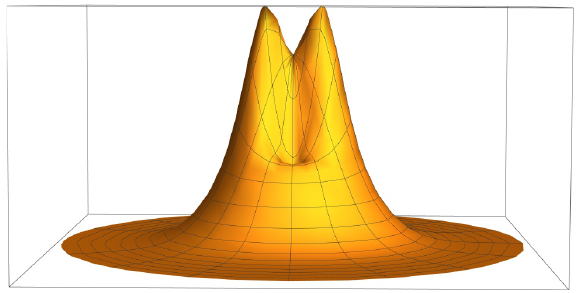
Figure 2. Positive representation of an exponential of a quartic monomial.